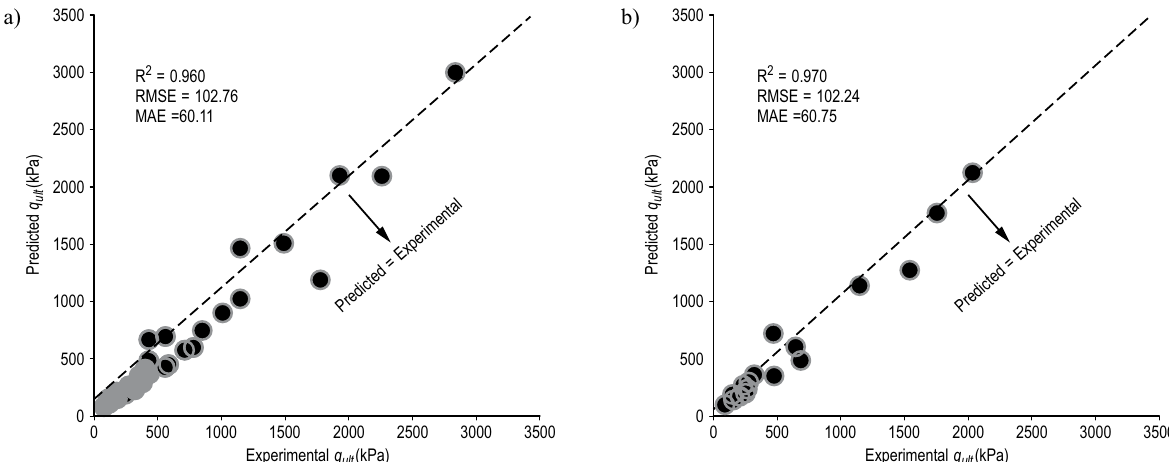
Fig. 7. Experimental versus predicted bearing capacity values using the LGP model: (a) training data, and (b) testing data